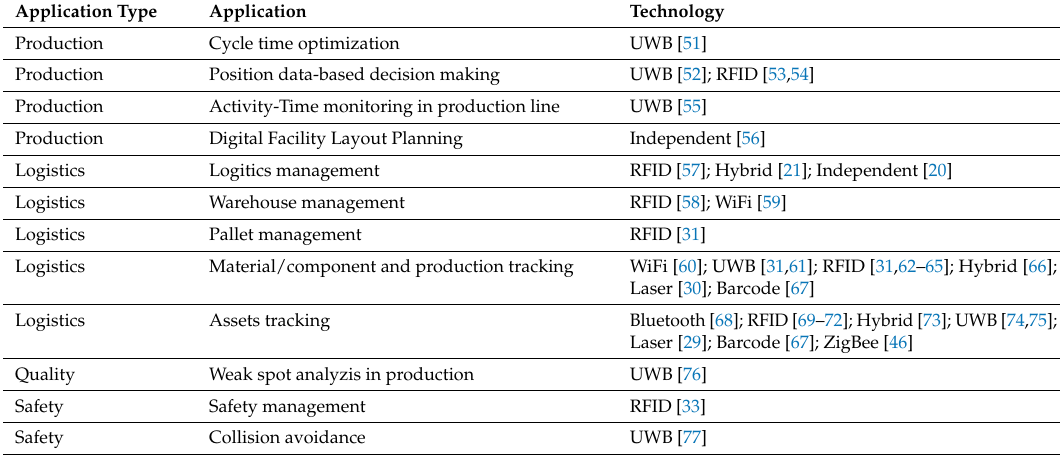
Table 3. Industrial applications of RTLS